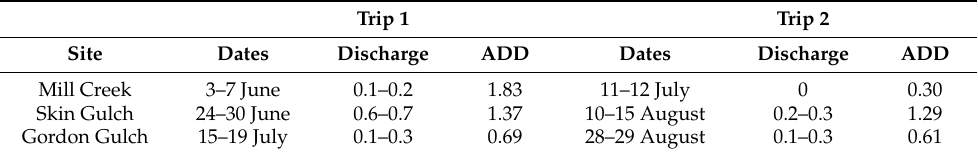
Table 2. Field survey summaries, with dates in 2016, area-normalized stream discharge at the catchment outlet (mm day − 1 ), and active drainage density (ADD) in km km − 2 . Trip 1 Trip